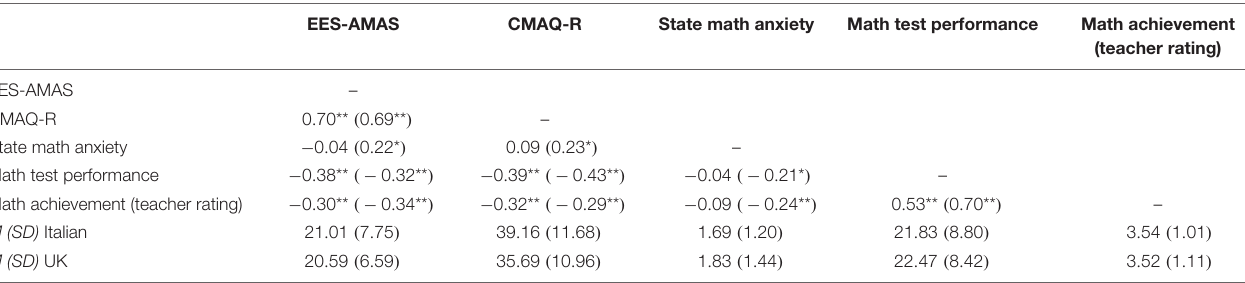
TABLE 6 | Descriptive statistics for the measures, and correlations between the measures of math achievement and math anxiety (results for the UK sample are presented in brackets). EES-AMAS